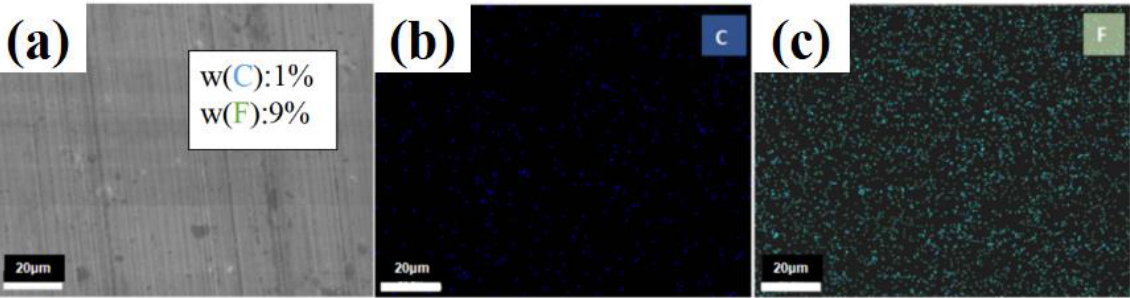
Figure 9. ( a ) EDS analysis of PTFE/PS’s wear track; distribution map of the ( b ) C element and ( c ) F element.